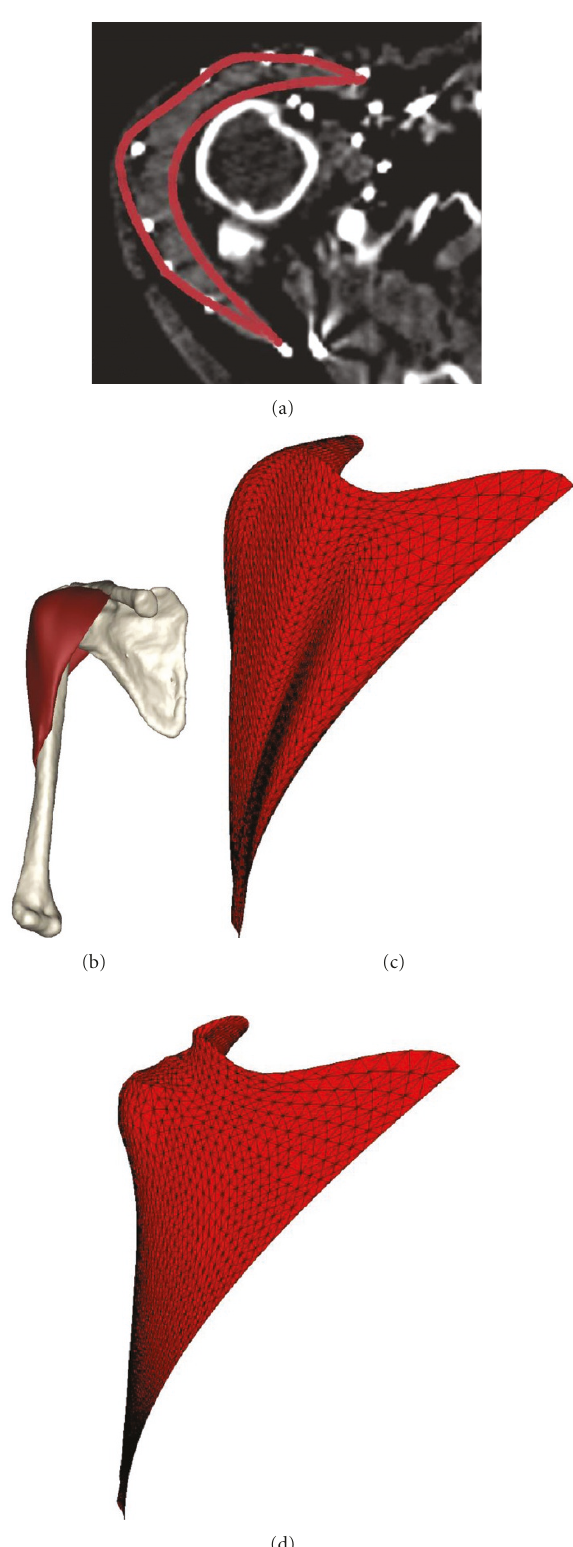
Figure 8: (a) Contour of the deltoid volumetric mesh on an axial CT image. (b) The deltoid volume was created by fusion of the calculated inner and outer surfaces. (c) Separate visualization of the inner en outer surface mesh of the deltoid